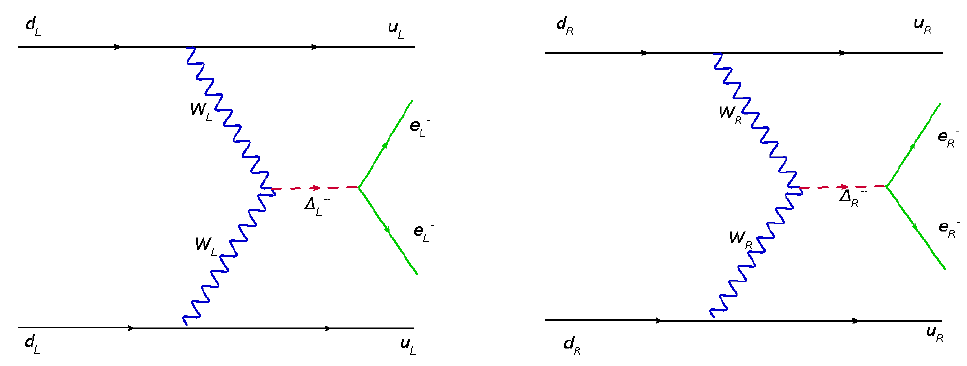
Figure 4 . Feynman diagrams corresponding to neutrinoless double beta decay due to (cid:1) L (cid:0) W L (cid:1) R (cid:0) W R contributions.